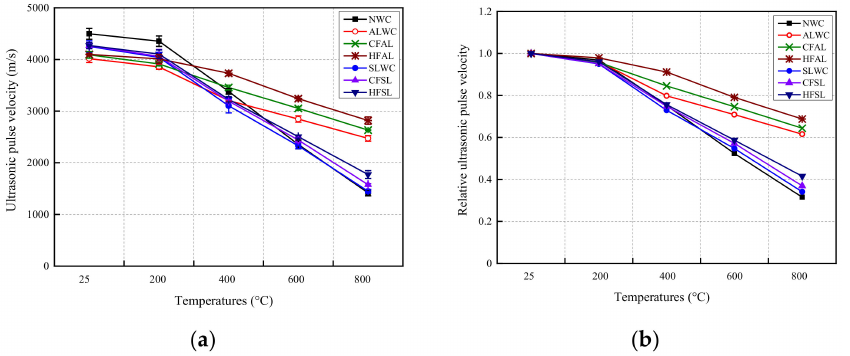
Figure 5. Ultrasonic pulse velocities of the studied concrete after the fire: ( a ) absolute UPV; ( b ) relative